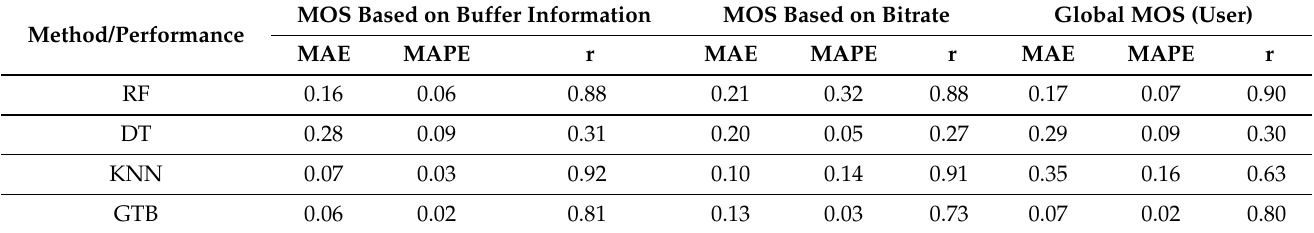
Table 12. MOS scores prediction performance results using 80% for training and 20% for testing with 5-fold for cross